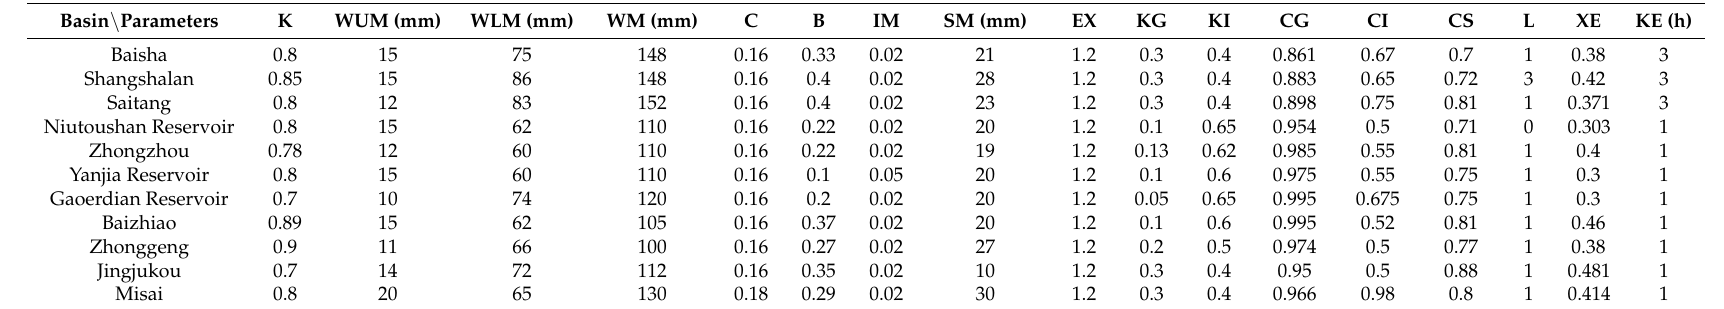
Table 7. Calibrated Xinanjiang model parameters of the studied basins.